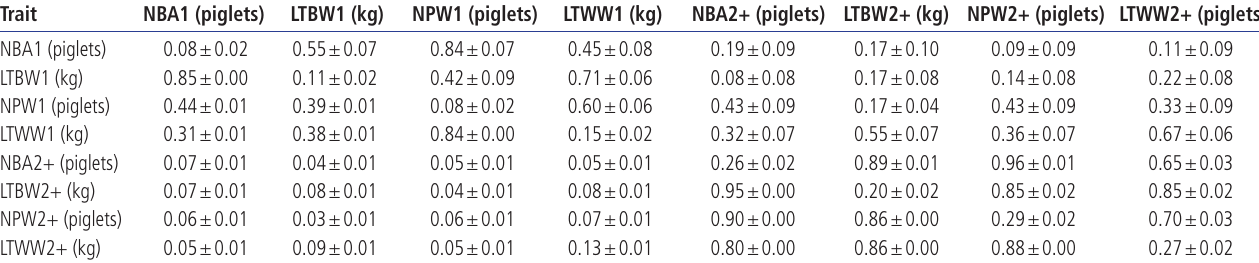
Table 4. Estimates of heritabilities (±SE; diagonal), phenotypic correlations (±SE; below diagonal), and genetic correlations (±SE; above diagonal) for first parity and sums from second to last parity reproduction traits